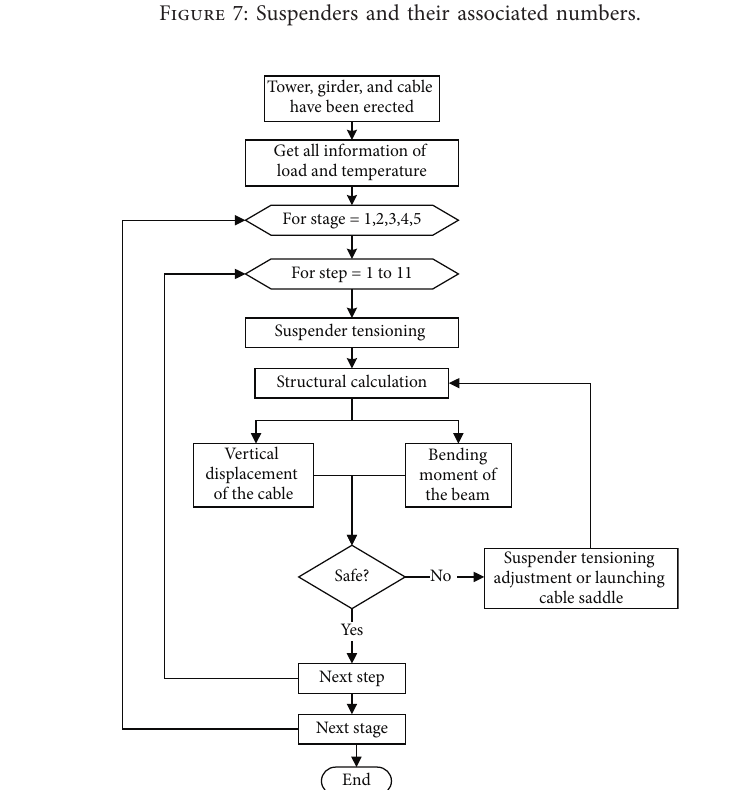
Figure 8: Analysis flowchart of suspender tensioning for the self-anchored suspension bridge.